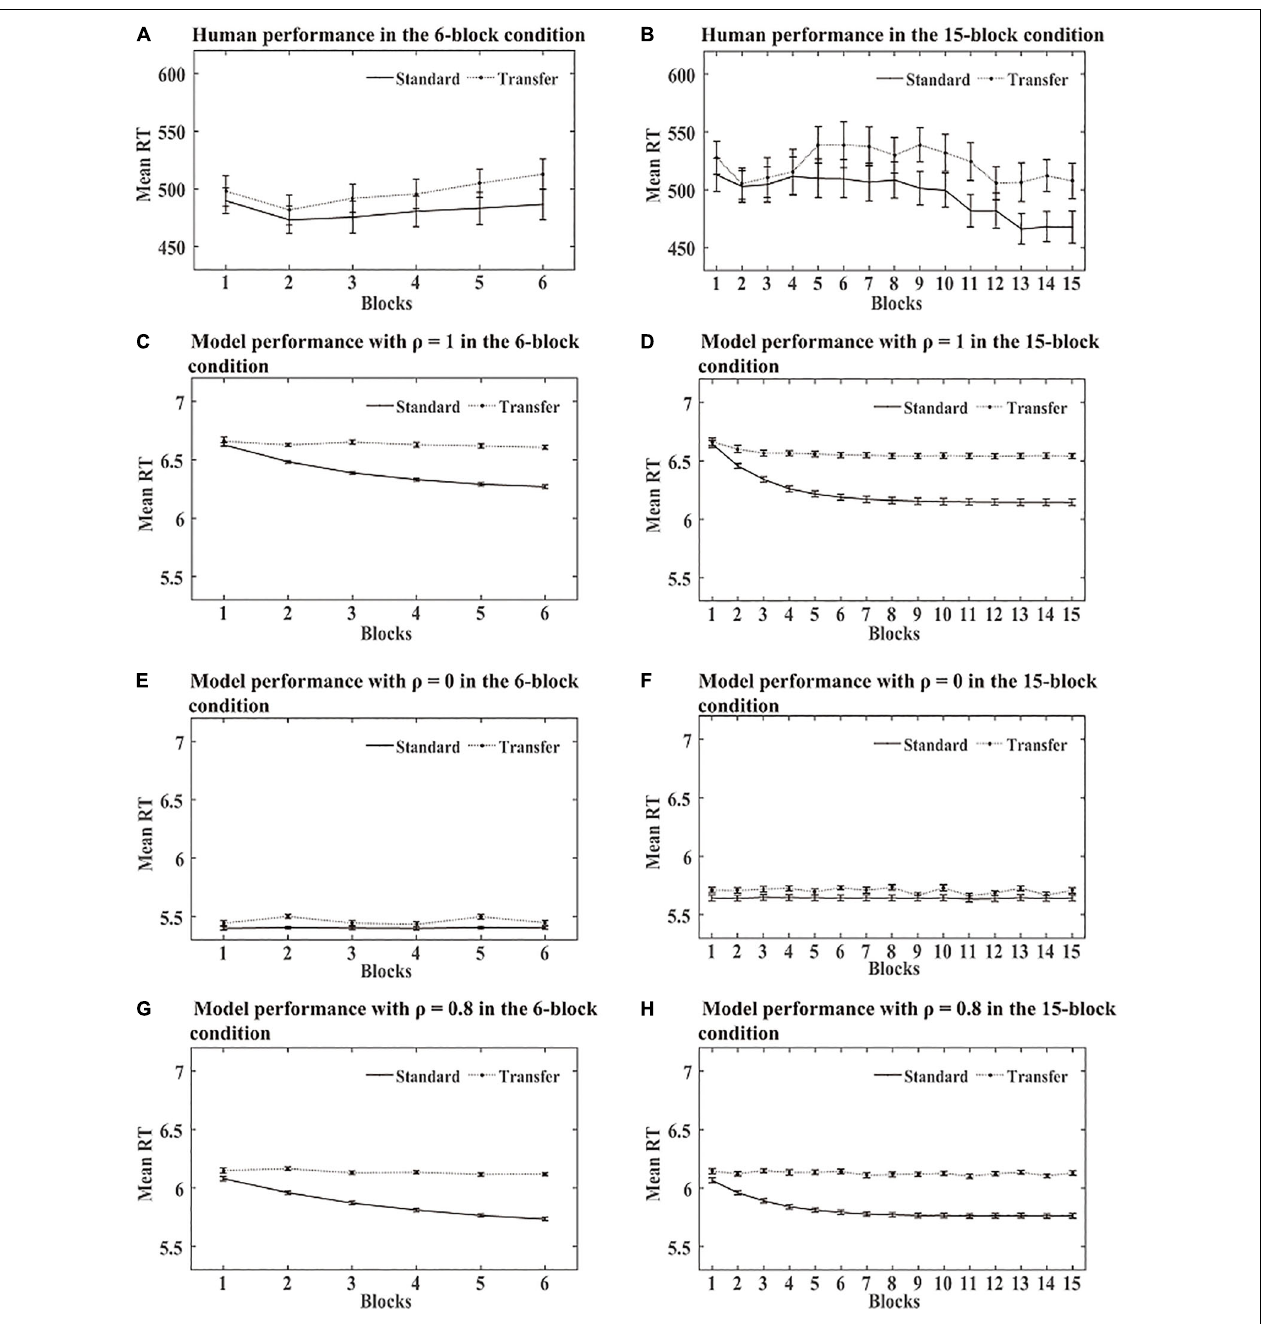
FIGURE 5 | Human and model performance in the SRT task in Simulation 2. (A) Mean RTs for human participants in the 6-block group. (B) Mean RTs for human participants in the 15-block group. (C,E,G) Mean RTs for models with different ρ values in the 6-block condition. (D,F,H) Mean RTs for models with different ρ values in the 15-block